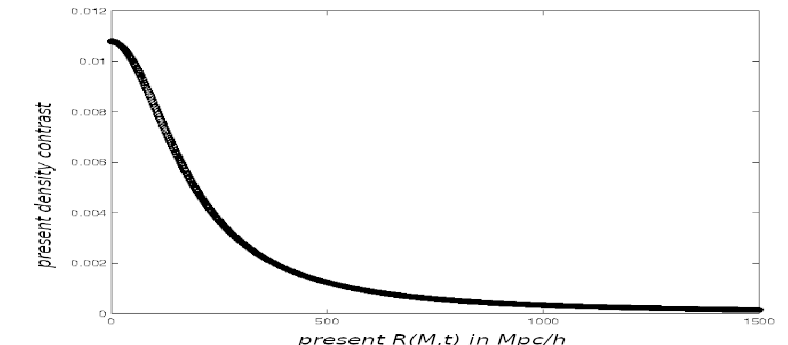
Figure 3. Present linear density contrast as a function of R , for the perturbations O 1 – O 7 , with R v ( t 0 ) = 180 h − 1 Mpc and ε ( t 0 ) = 0.0108. The initial values at t D that generate each overdensity appear in Table